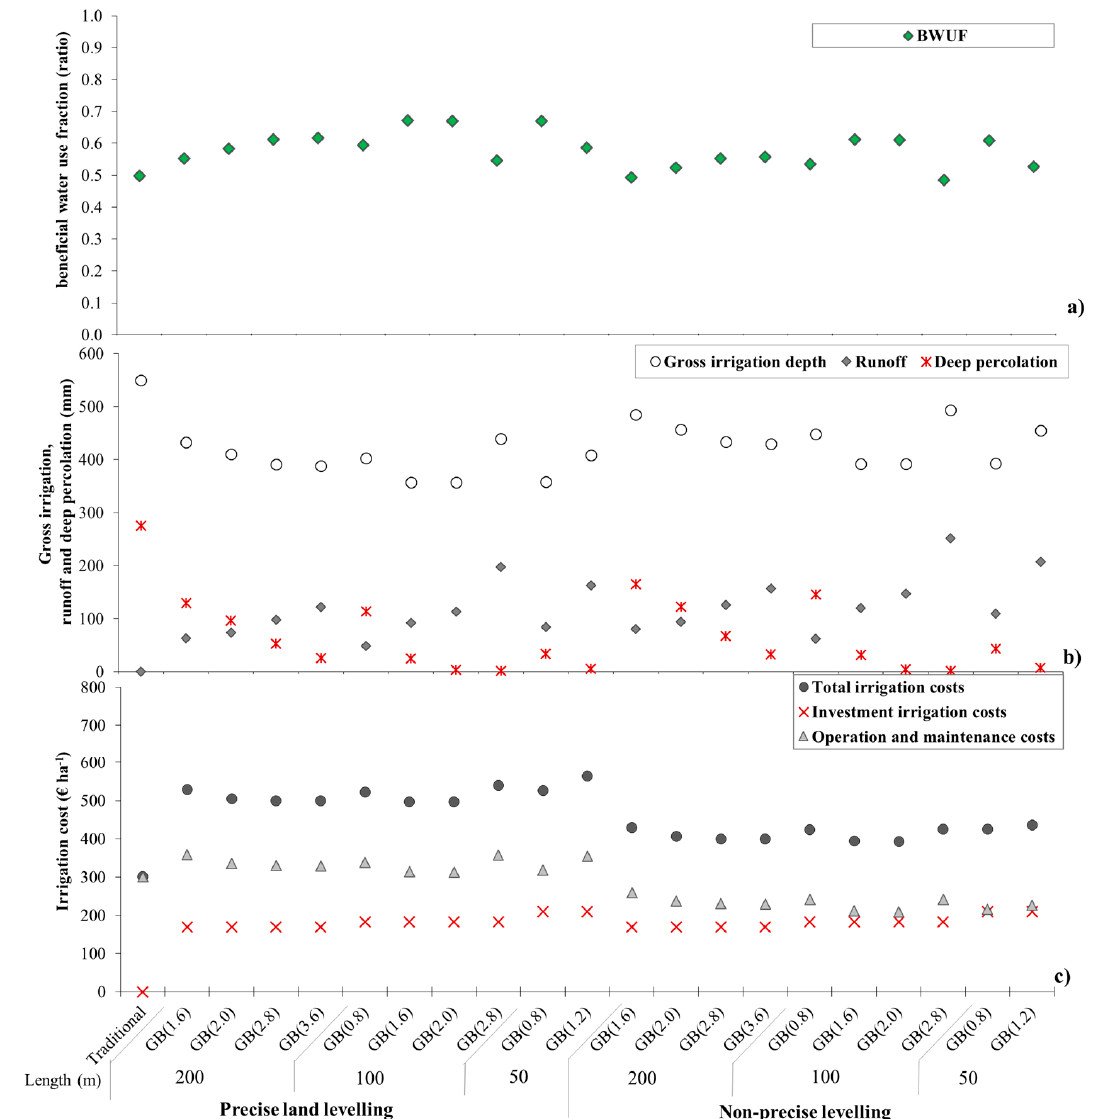
Figure 5. Comparing design alternatives for graded borders (GB) relative to: ( a ) beneficial water use fraction; ( b ) gross irrigation, runoff and deep percolation (mm); and ( c ) irrigation costs ( € · ha − 1 ). Values inside brackets refer to inflow rates (L · s − 1 · m − 1 ).